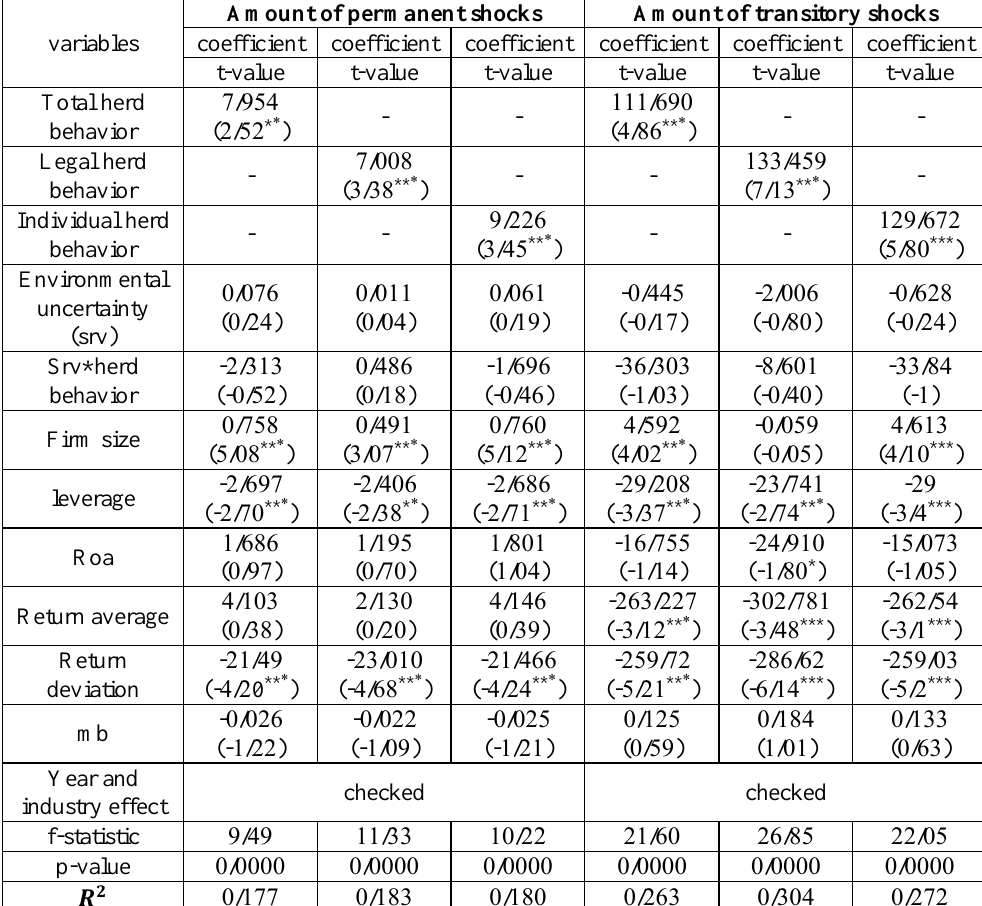
Table 4. effect of environmental uncertainty on the relationship between herd behavior (total, legal, individual) and amount of permanent and transitory